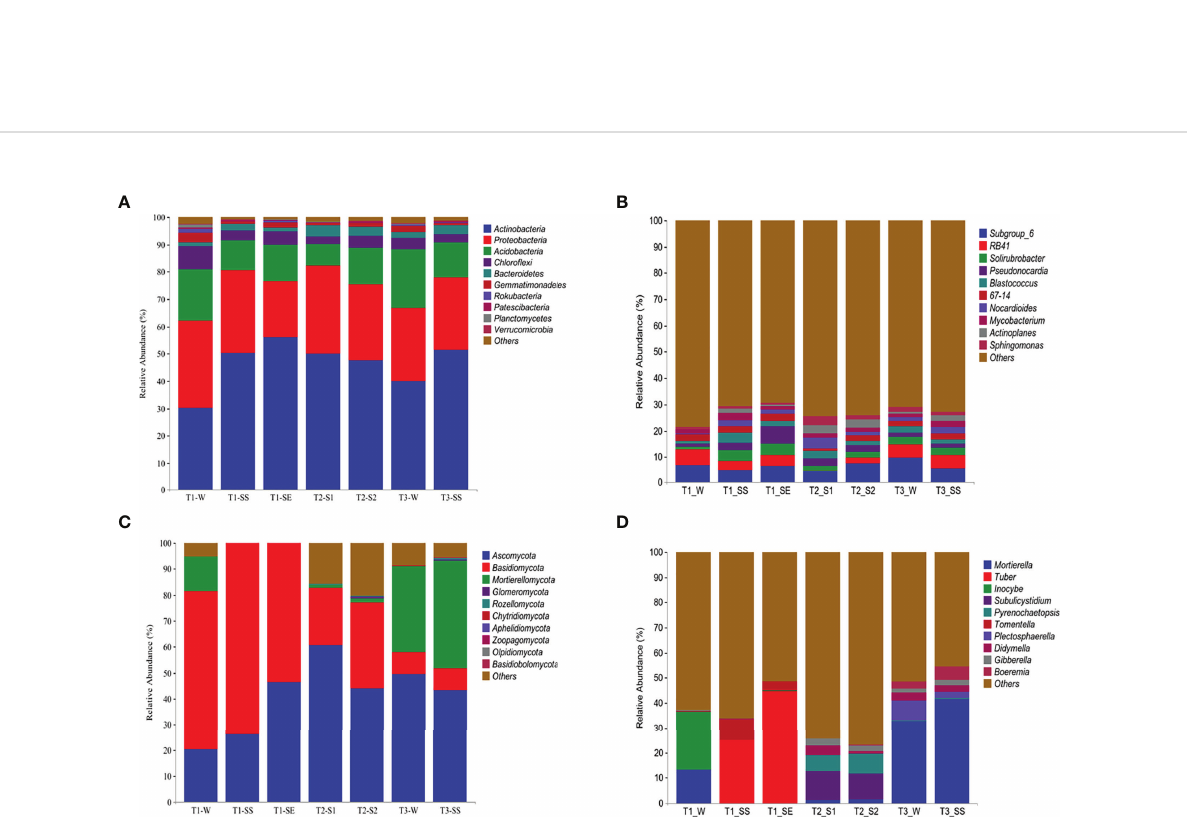
FIGURE 8 Taxonomic proportions of bacterial and fungal diversities beneath Pinus (T 1 ), Robinia (T 2 ), and Hippophae (T 3 ) at phylum (A, C) and genus (B, D) levels.